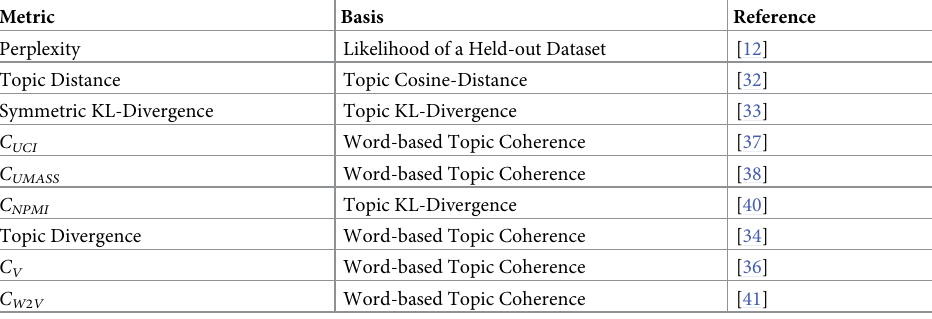
Table 2. Internal metrics for topic modeling result assessment included in the experiments of this study. Metric